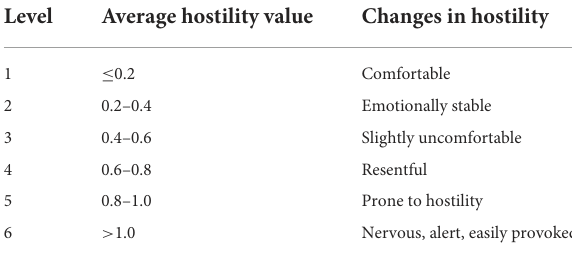
TABLE 4 Health risk assessment criteria for hostile